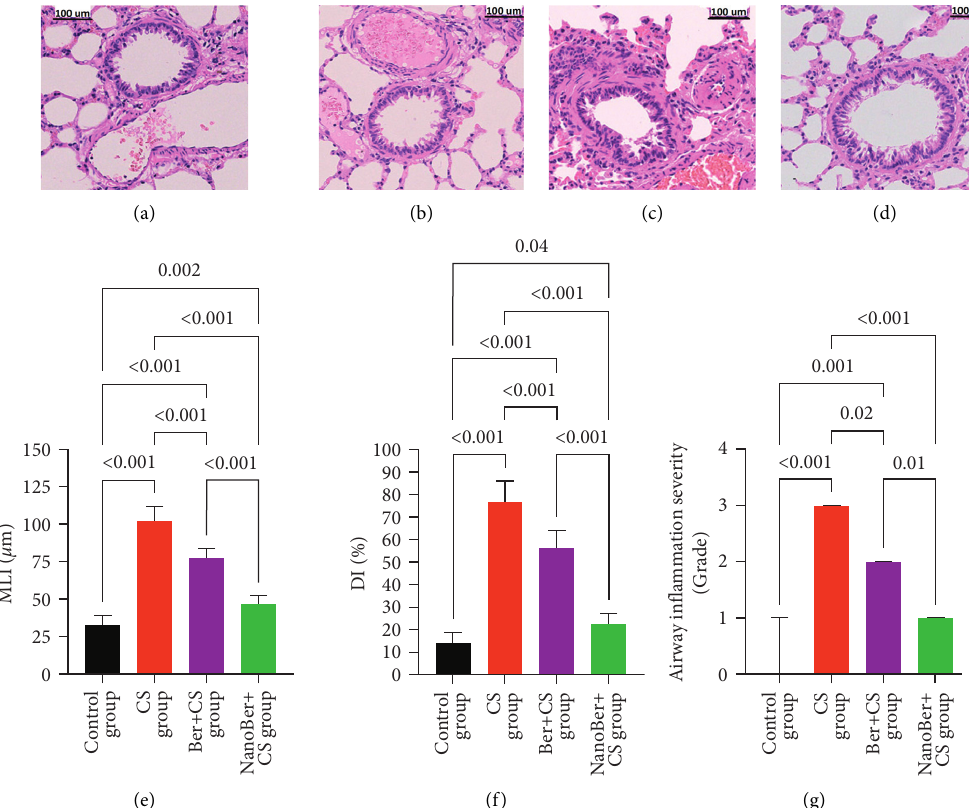
Figure 4: The effect of Ber-loaded SLN-chitosan nanoparticles and the pure suspension of berberine on CS-induced lung histological alterations. Representative H&E staining images of lung tissue sections from the control group. (a) CS group, (b) Ber+CS group, (c) NanoBer+CS group, (d) under an optical microscope (original magnification × 200, scale bar 100 µ m). MLI ((e) and DI (f) values were calculated to estimate changes in the airway space size and structure. Data are expressed as mean ± SD ( n � 10). The severity of airway inflammation was graded on a 0–3 scale. Data are expressed as median (25%–75% percentile) ( n � 10) (g). Statistical analysis was carried out by one-way analysis of variance (ANOVA) followed by Tukey’s multiple comparison test. p < 0 . 05 is considered as statistically